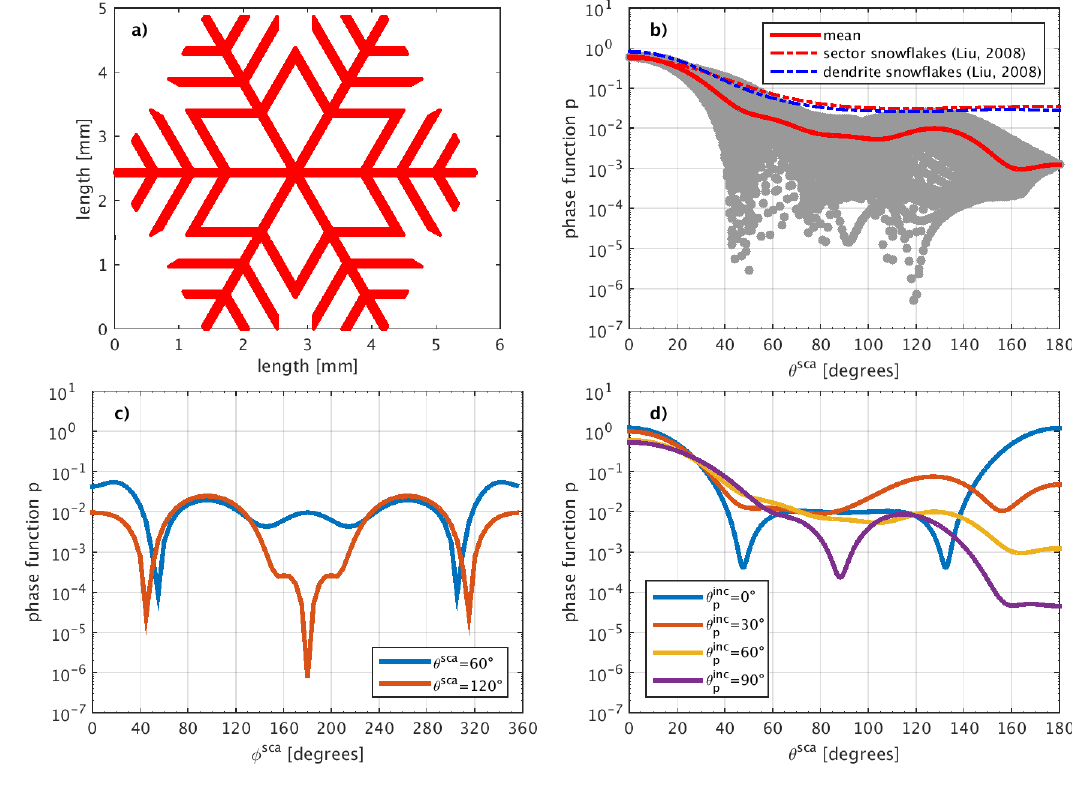
Figure 6. (a) Morphology of the 361st branched planar crystal in the database. (b) The phase function p (grey dots) of the 361st branched planar crystal as a function of scattering polar angle θ sca for incident radiation with θ inc θ sca there are 72 grey dots, representing values for each of the 72 different scattering azimuth angles φ sca . The phase function averaged over the 72 values of φ sca is represented by the solid red line. The dashed red and blue lines represent the phase functions of the sector snowflake and dendrite snowflake from Liu (2008) with a similar maximum dimension. (c) The phase function p of the 361st branched planar crystal for (blue) θ sca = 60 ◦ and (red) θ sca = 120 ◦ as a function of scattering azimuth angle φ sca for incident radiation with θ inc = 0 ◦ . (d) The phase functions p (averaged over scattering azimuth angle φ sca ) of the 361st branched planar crystal as a function of φ inc P scattering polar angle θ sca for radiation with incident polar angles θ inc results in (b) , (c) , and (d) were obtained from DDA calculations at the W-band